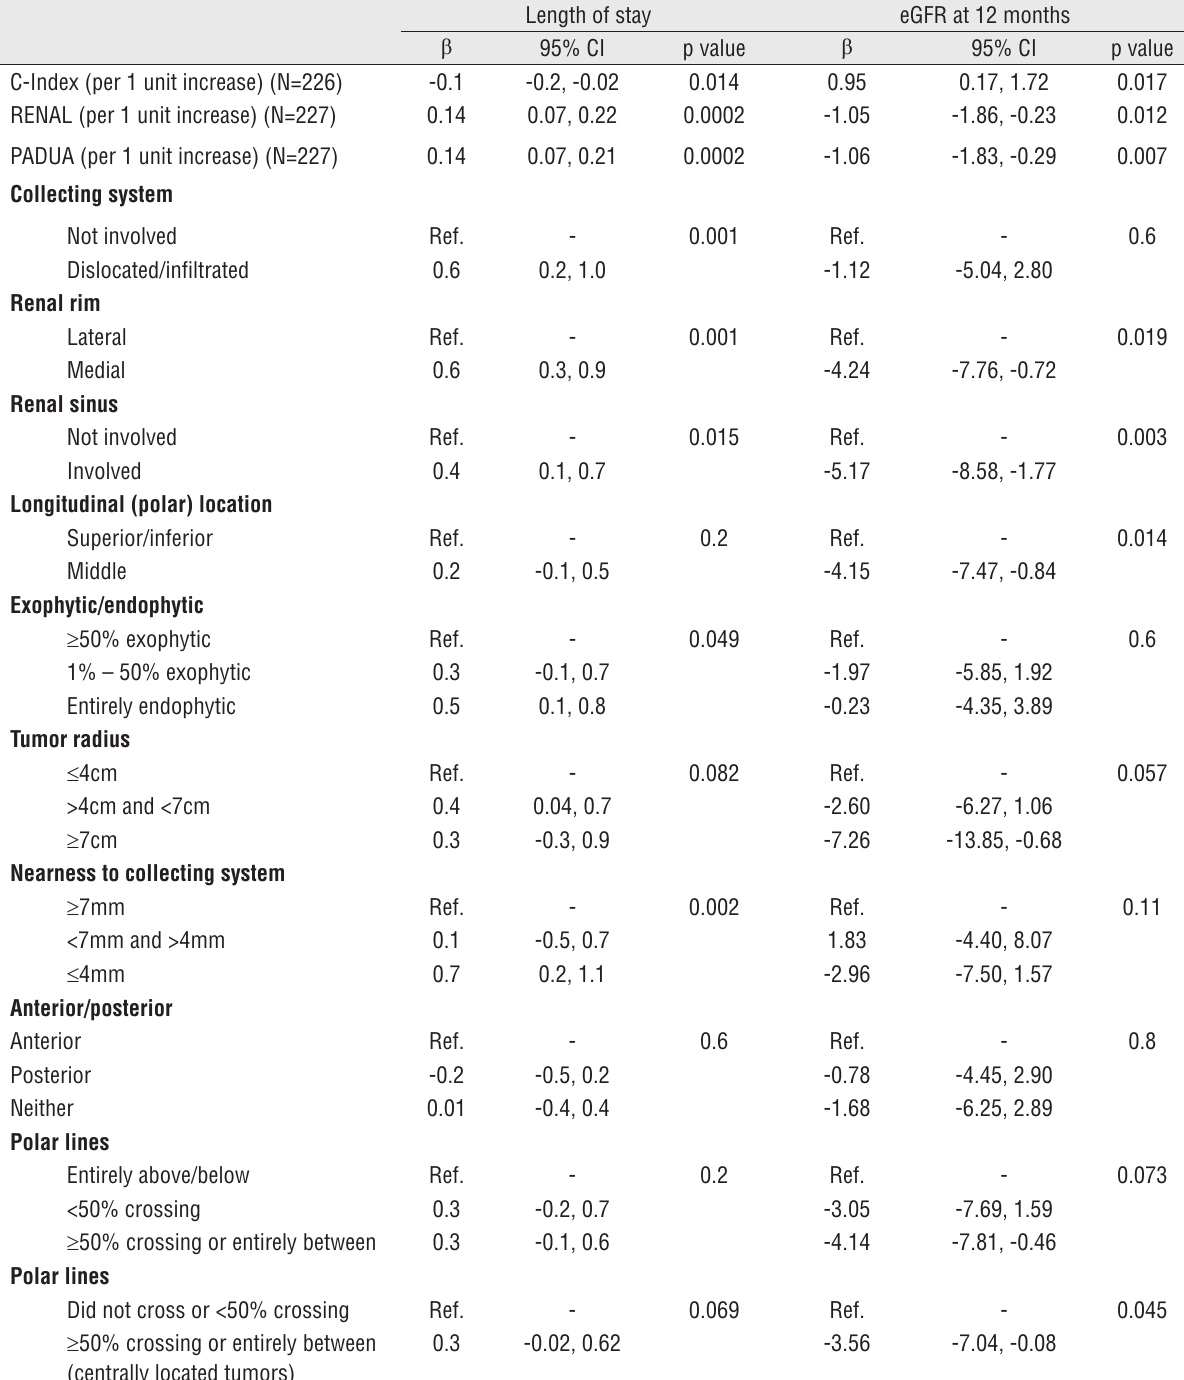
Table 4 - Multivariable linear regression models for the association between c-index, REnAL and pADuA total scores subscales and postoperative outcomes. The model for length of stay (LOs) in days was adjusted for AsA score and age (n =